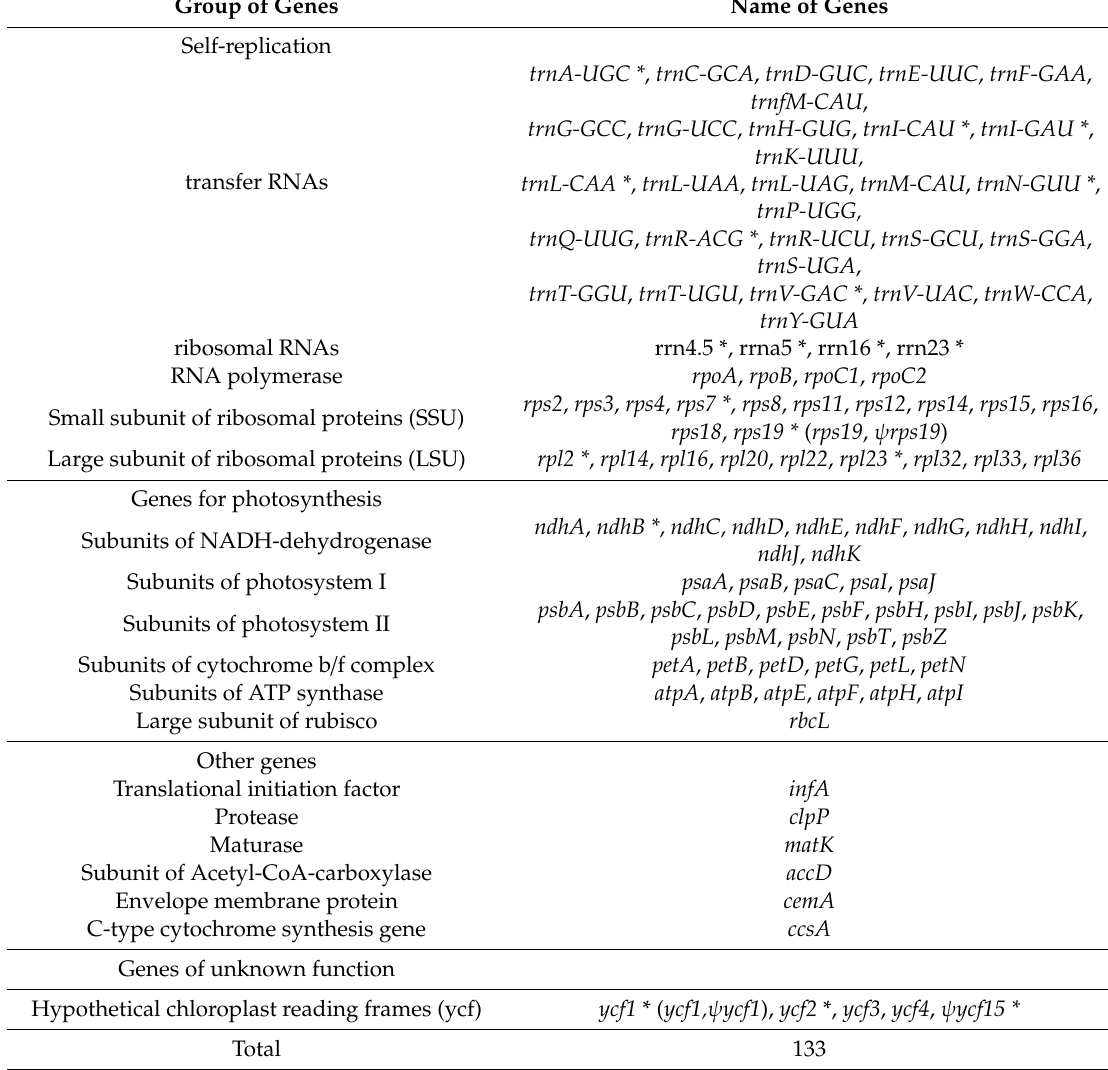
Table 1. List of genes encoded in nine Chamaesium species. Group of Genes Name of